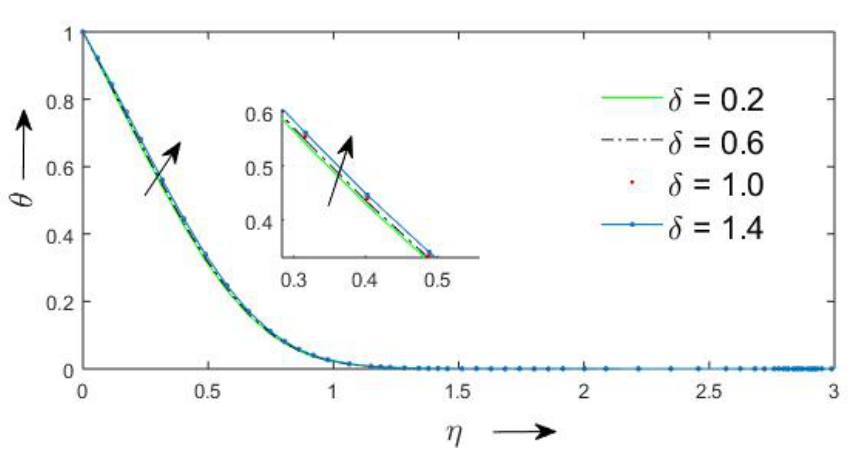
Figure 9: Distribution temperature due to δ